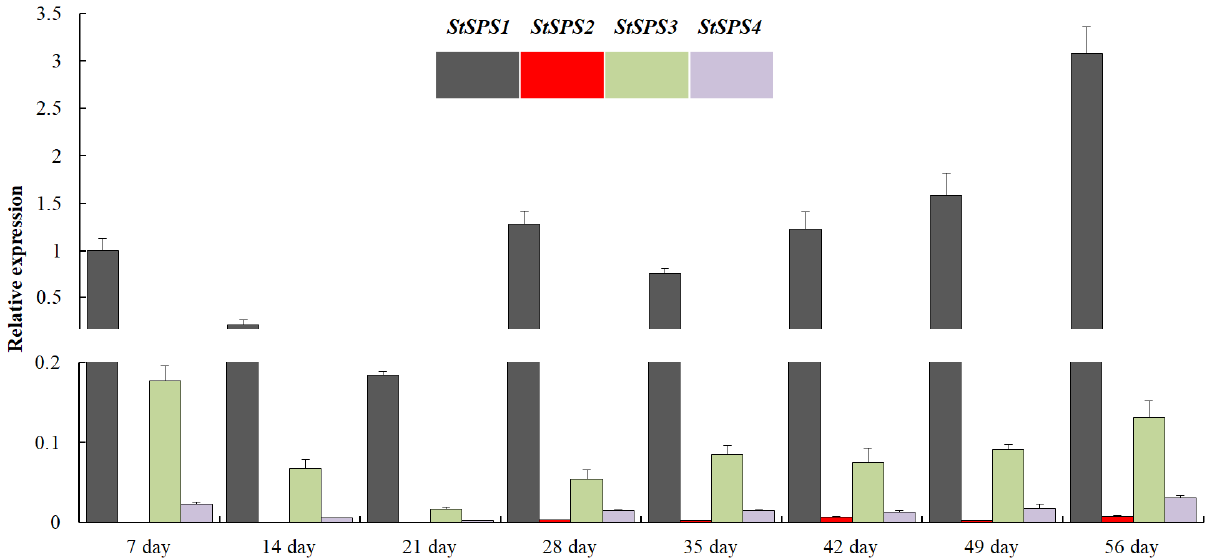
Figure 4. Expression of StSPS family genes in bud eyes tissue during tuber storage (qRT-PCR).